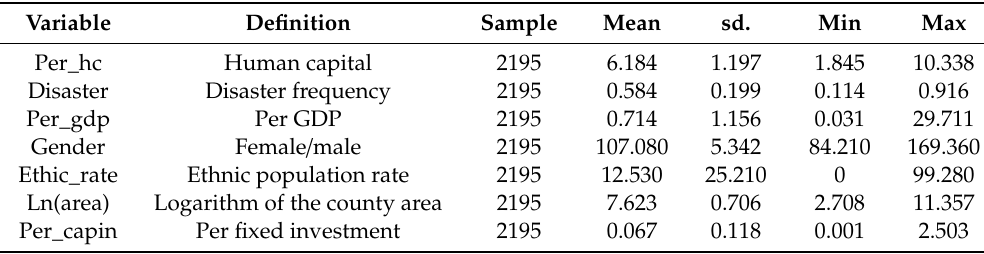
Table 1. Descriptive statistics for